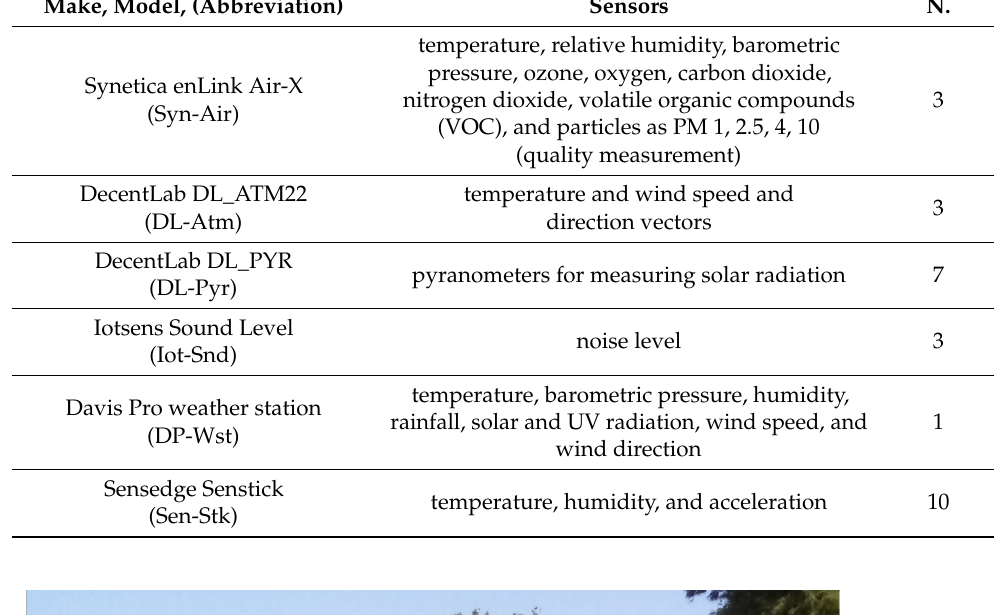
Table 1. List of sensors and models, with the number (N) installed in the garden.